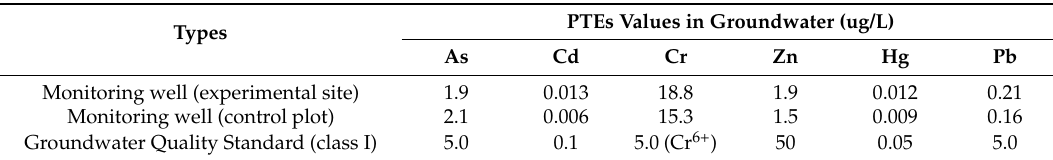
Table 6. PTEs values in shallow groundwater of monitoring wells